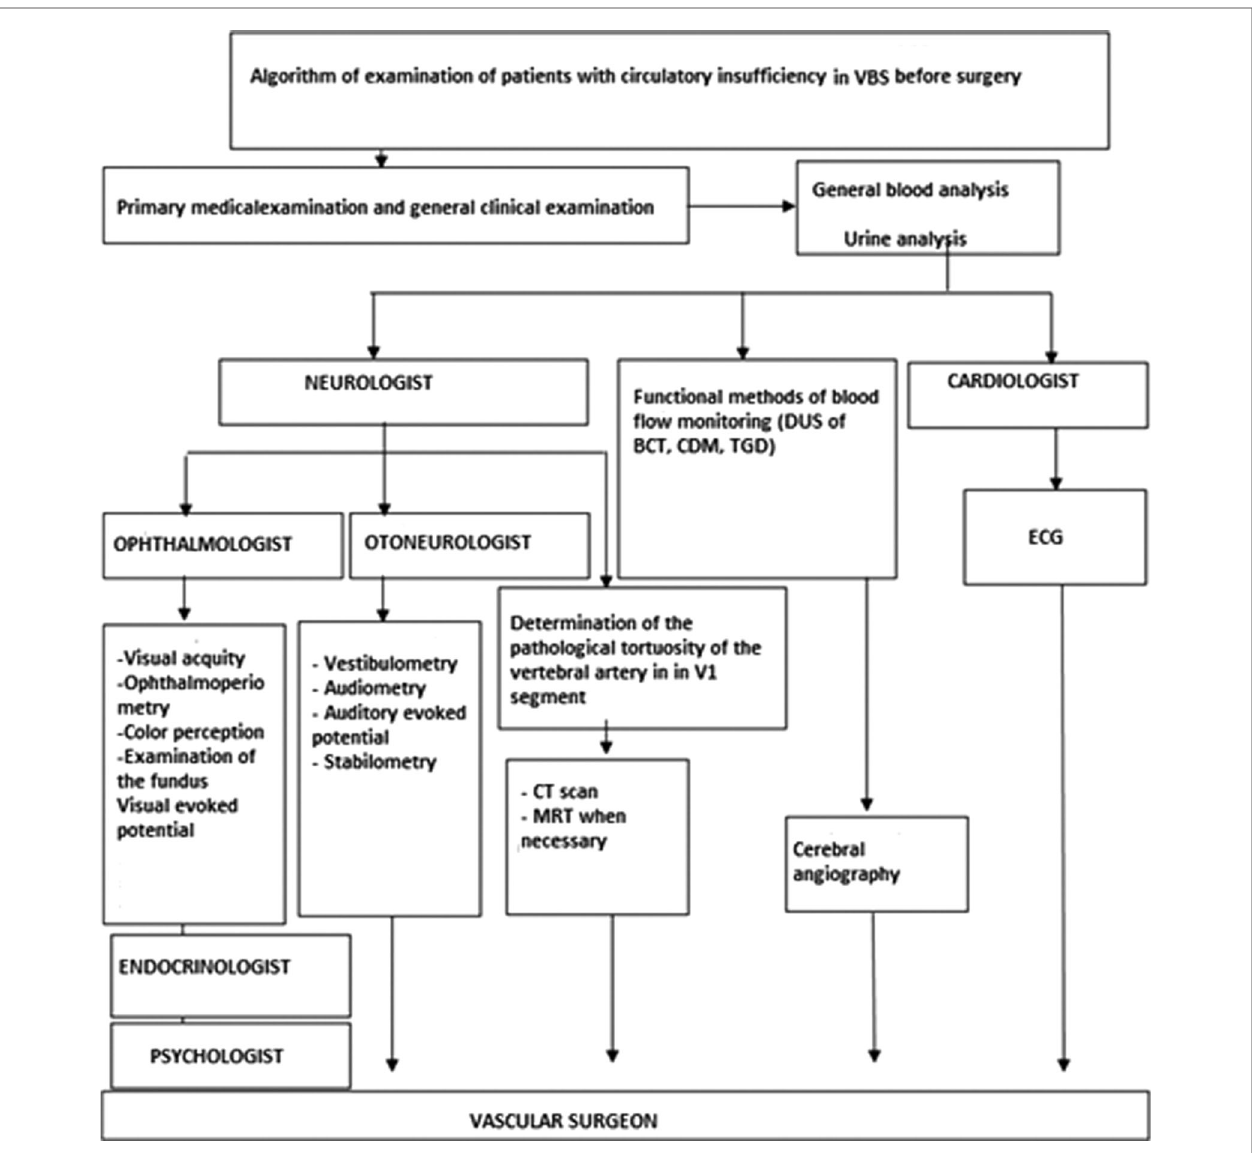
FIGURE 2 | Algorithm for examination of patients with vertebrobasilar insuf fi ciency (VBI). Note: DUS, Doppler ultrasound; BCT, Brachiocephalic trunk; VBI, Vertebrobasilar insuf fi ciency; ECG, Electrocardiogram; CT, Computed tomography; MRT, Magnetic resonance